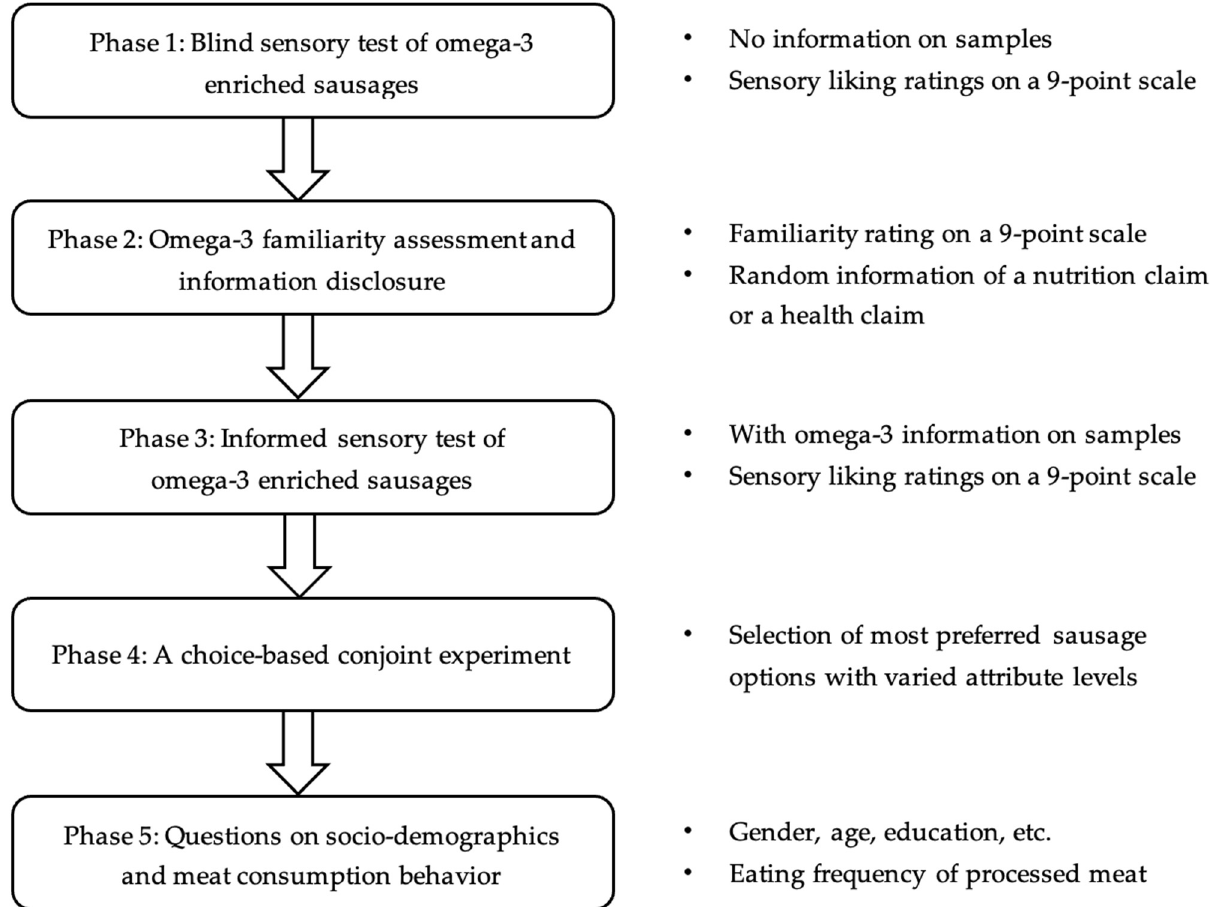
Figure 1. A diagram of the experimental procedure.